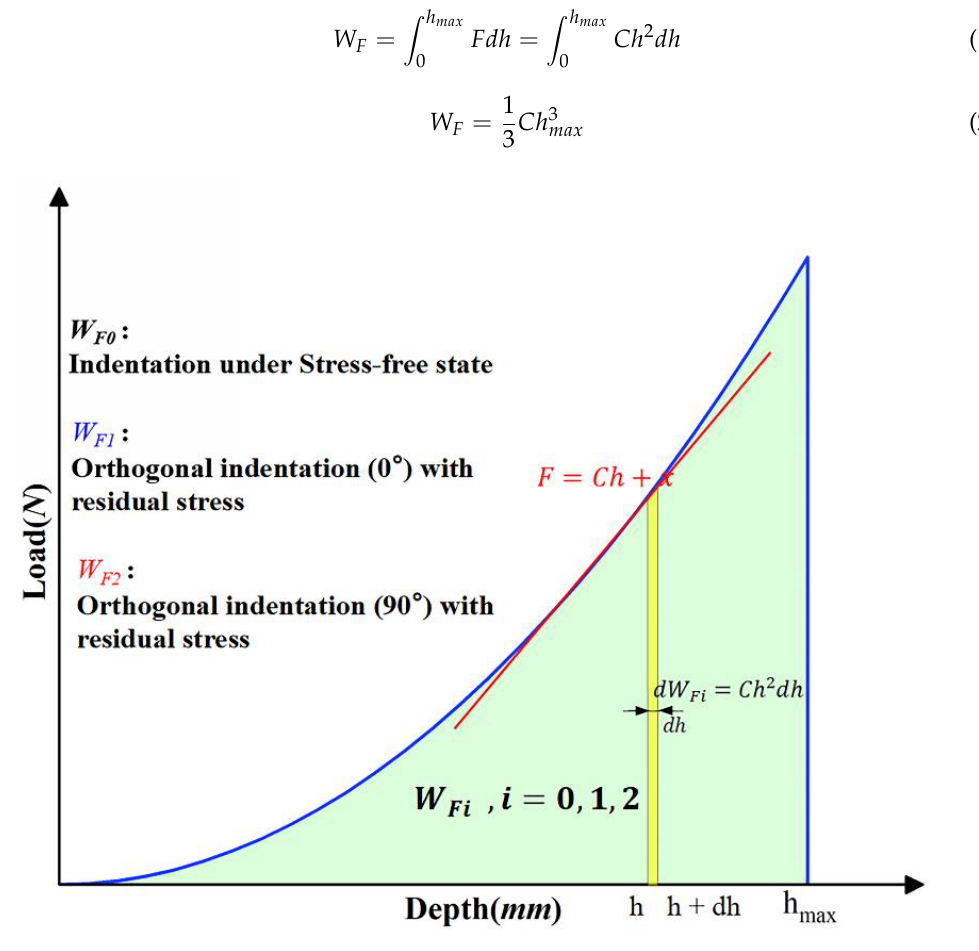
Figure 2. Graphical Representation of Indentation energy.